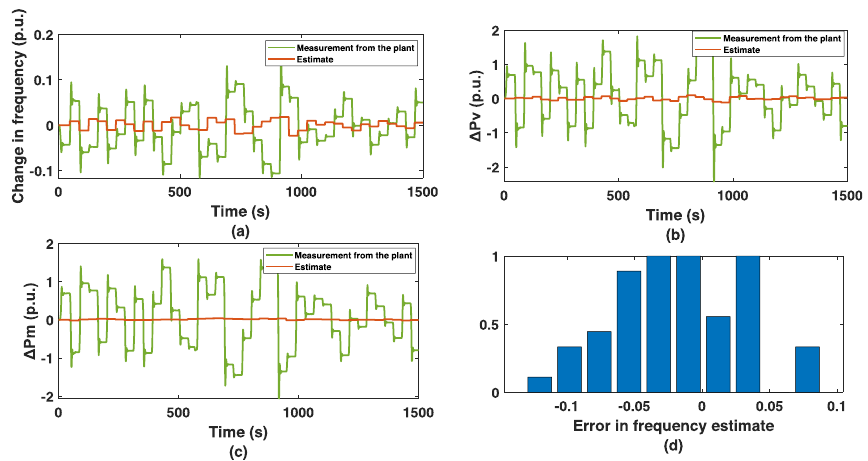
Fig. 12 a , b and c Variation of states f, P v and P m in response to disturbance along with the estimate from the observer; d Normalized histogram of error in frequency estimate for a measurement noise variance of 0.1